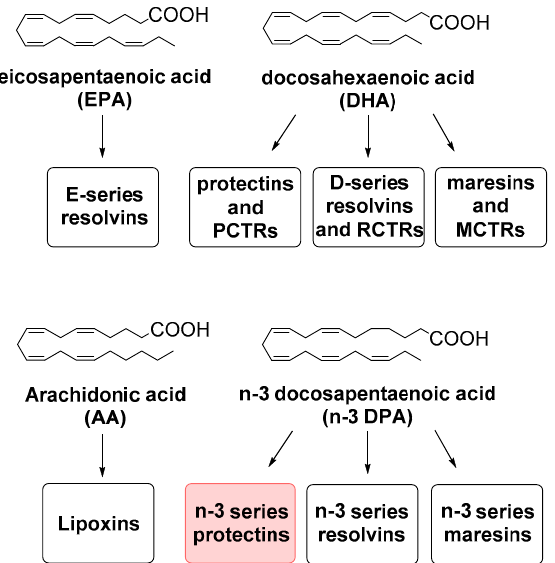
Figure 1. Overview of families of specialized pro-resolving mediators (SPMs) derived from eicosapentaenoic acid (EPA), docosahexaenoic acid (DHA), arachidonic acid (AA), and n-3 docosapentaenoic acid (DPA).